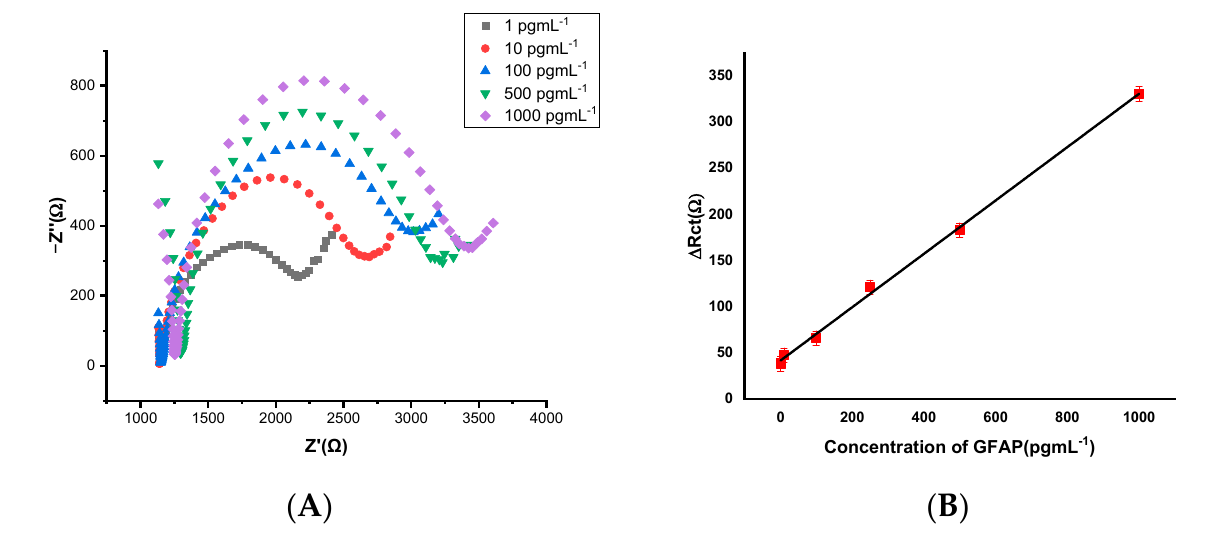
Figure 7. The analytical performance of the GFAP biosensor with the EIS results ( A ) and calibration curve, ( B ) type of signal transducer, application of nanomaterials, detection technique, type of bioreceptor, type of redox marker. Table 2. The comparison of GFAP with previous